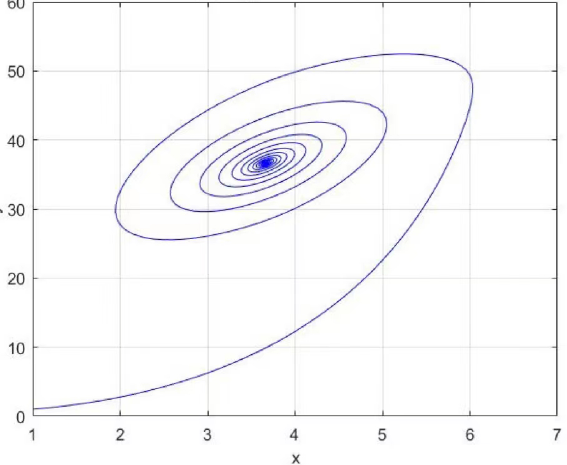
Figure 2. The stable phase trajectory with delay in a stable interval.